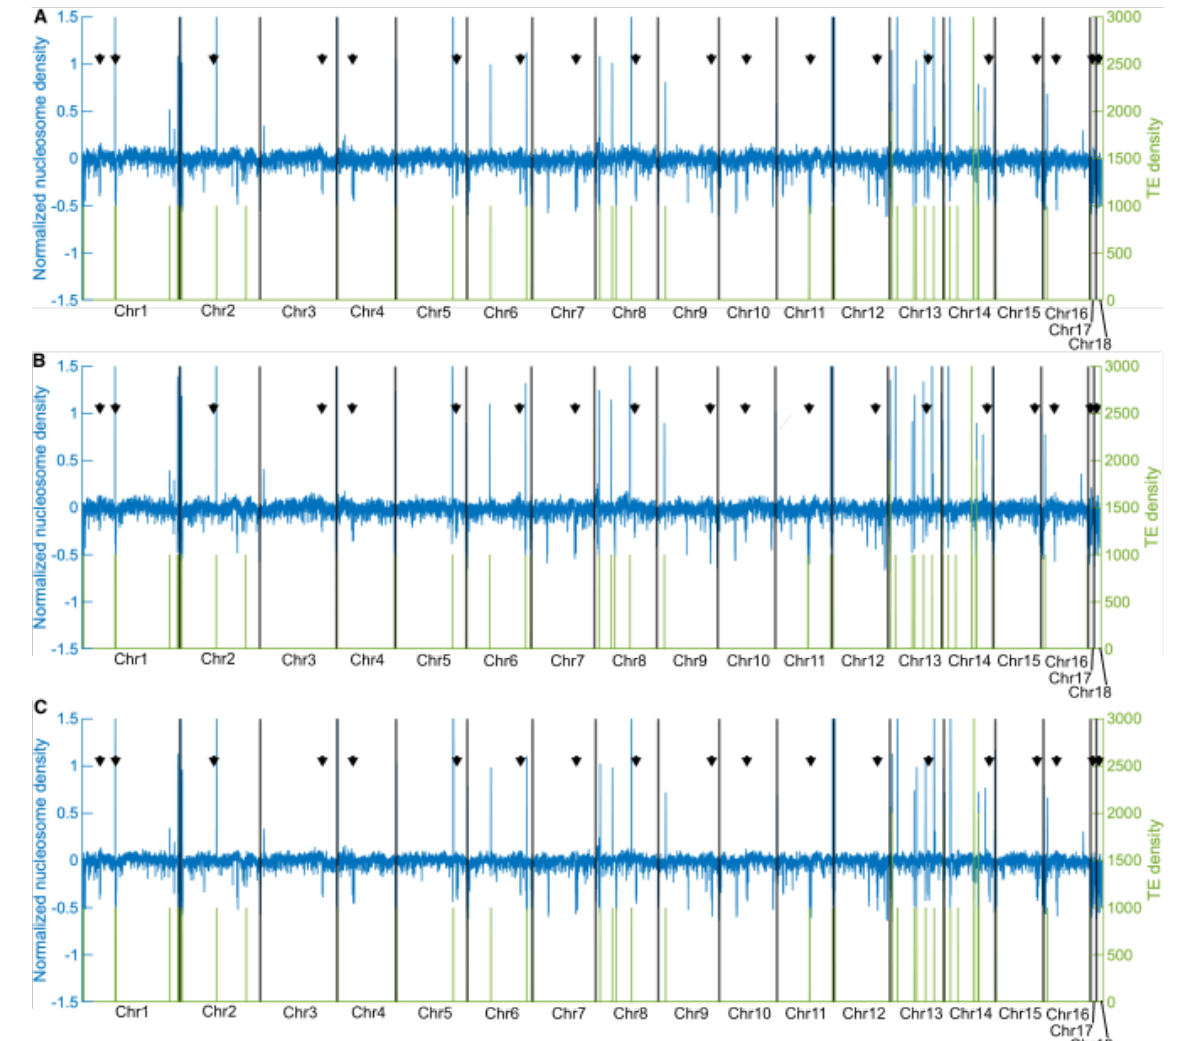
Supplementary Figure 2. Nucleosome vs . BOTY TE density profiles in individual biological replicates of Botrytis cinerea . Coverage density profiles were computed for non-overlapping 1 kb-long bins along the chromosomes. In green are plotted BOTY transposable elements (TE) density profiles as previously described (Diolez et al. , 1995). In blue are plotted the z- scored nucleosome density profiles. Black arrows indicate centromeres. ( A) . Biological replicate #1; ( B) . Biological Replicate #2; ( C) . Biological replicate